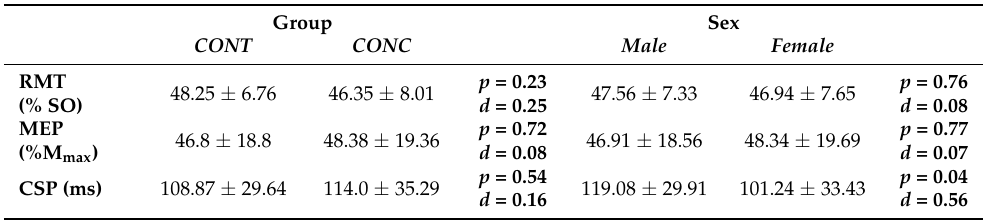
Table 2. Overall RMT, MEP, and CSP averages for groups and sexes; Values are presented as mean ± SD. SO = stimulator